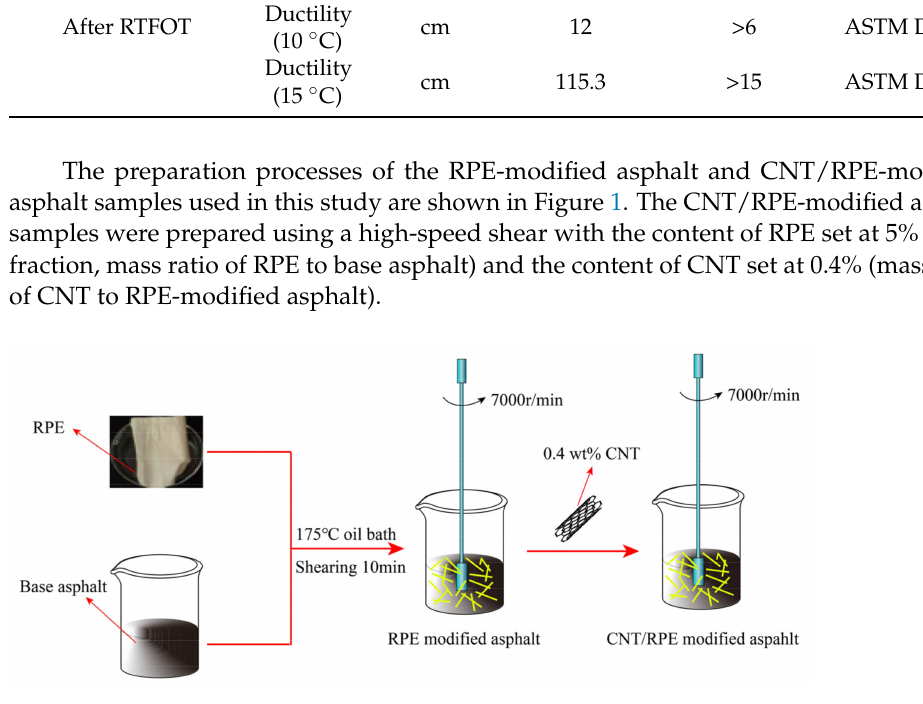
Figure 1. Sample preparation process of RPE-modified asphalt and CNT/RPE-modified